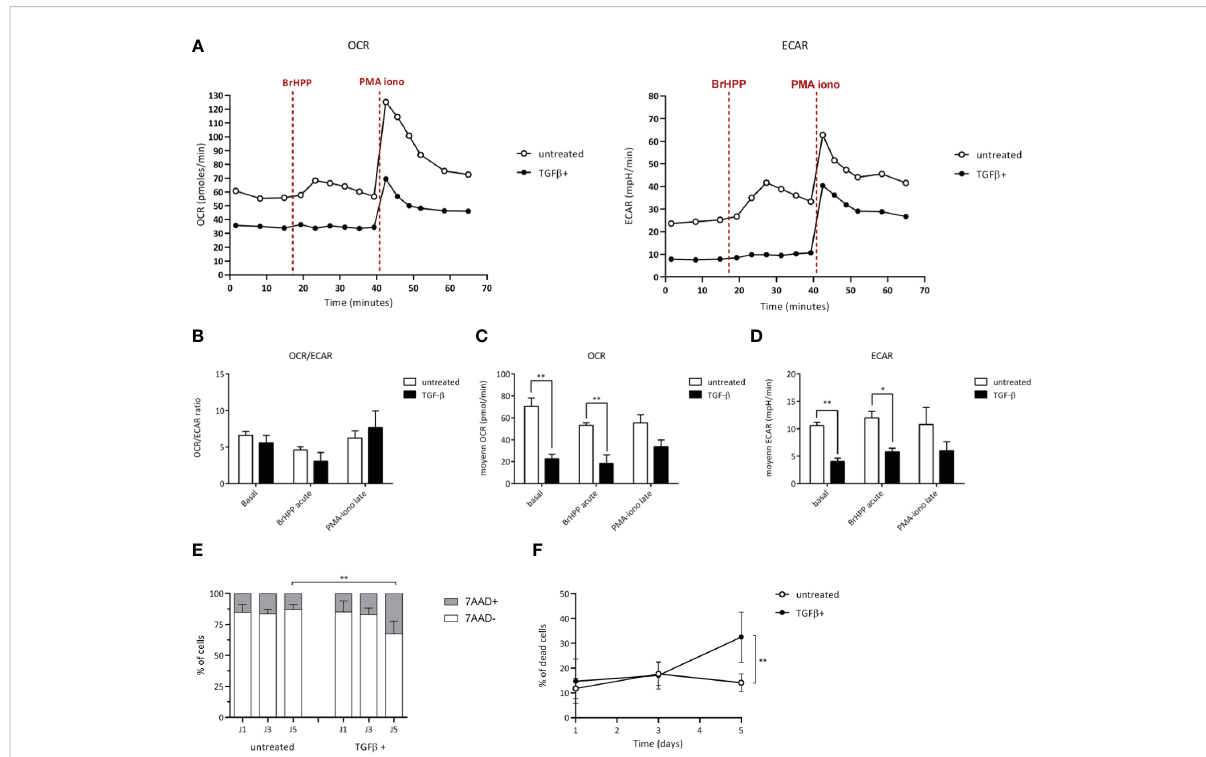
FIGURE 4 TGF- b alters the metabolism of V g 9V d 2 T cells. V g 9V d 2 T cells were treated ( closed symbols ), or not ( open symbols ), with TGF- b (10 ng/mL) for 72 h. Metabolic activities of T lymphocytes were measured using Seahorse XFp. (A-D) Monitoring of mitochondrial oxygen consumption rate (OCR) and extracellular acidi fi cation rate (ECAR) were performed at resting state, after BrHPP stimulation or PMA-ionomycin injection as described in the Materials and Methods section. (A) Representative experiments. Rates were calculated as follows: difference between the mean of the 3 values in the absence of substrate and the mean of the 4 values after injection of the substrate, as well as a ratio of the 2 for each condition (B-D) . (E) and (F) Cell death induced by TGF- b added within the media of V g 9V d 2 T cells (10 ng/mL for 72 h) was measured